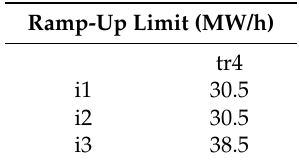
Table A9. Ramp-up limit of unit i (MW/h): ramp_up( i ).